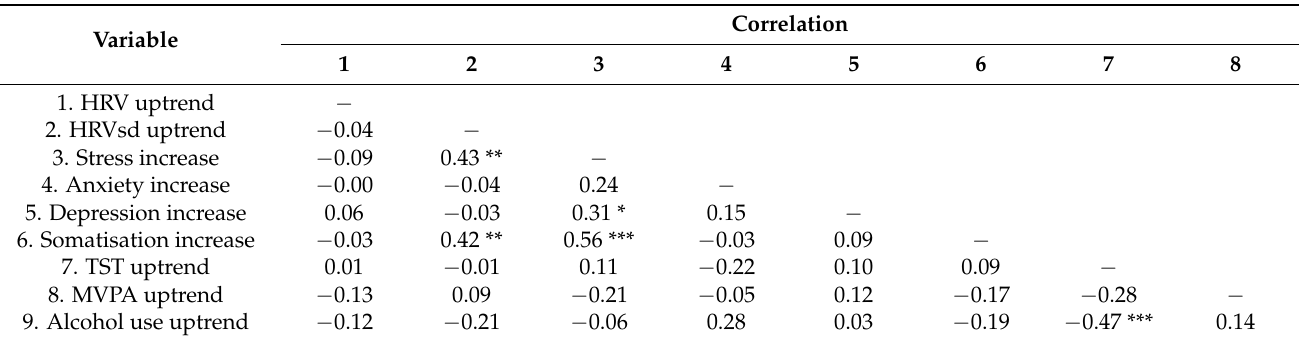
Table 1. Intercorrelations between the wearable (1–2), longitudinal (3–6), and control (7–9)